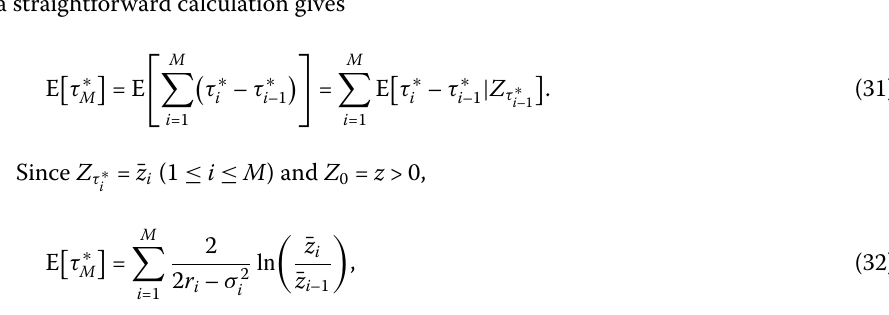
Table 1 Meaning of the variables and parameters of the present multiple optimal stopping problem in analyzing fish migration Parameter Meaning r i Deterministic growth rate of the population biomass in the habitat H i σ i Stochasticity involved in the growth of the population biomass in the habitat H i δ i Discount factor of the cumulative profit in the habitat H i q i Quality of the habitat H i